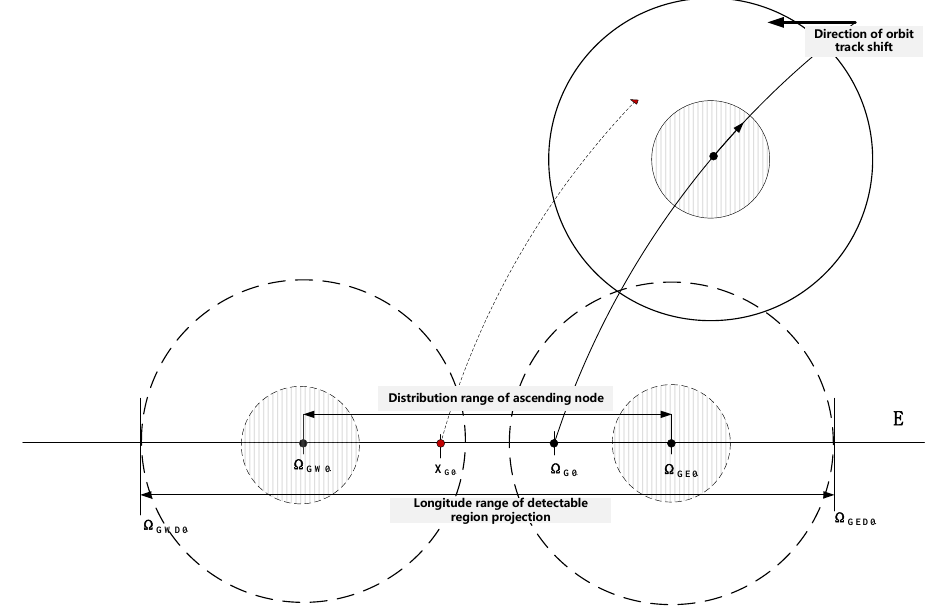
Figure 4. Selection method based on longitude section of ascending node.